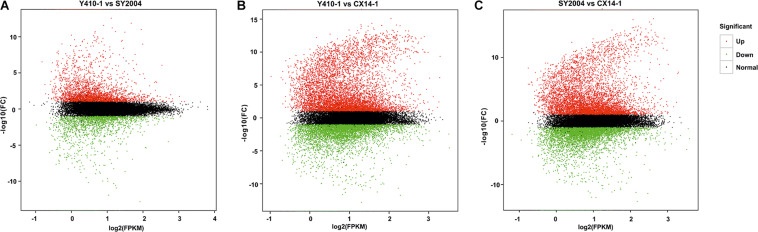
MA plot of differential expression for two samples. Each point represents the differentially expressed genes (DEGs). The x axis indicates log2(FPKM), and the y axis indicates log2(FC). The red and green dots represent significantly up- and downregulated genes, respectively; while black dots represent non-differentiated genes. FPKM, fragments per kilobase of transcript per million fragments mapped; FC, fold change.